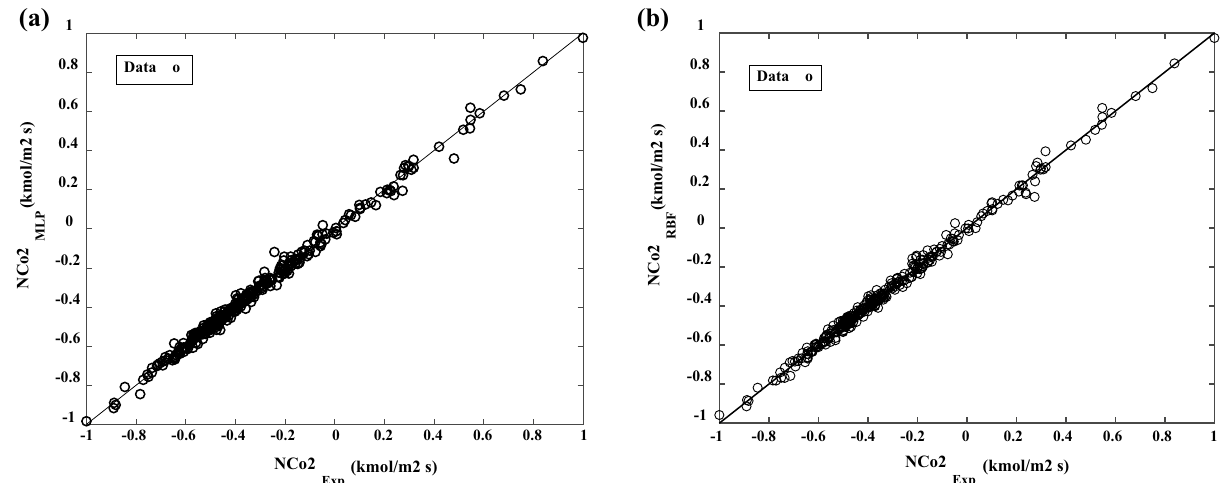
Figure 10. MLP ( a ) and RBF ( b ) normalized models fitting for experimental and predicted absorption flux ( N CO2